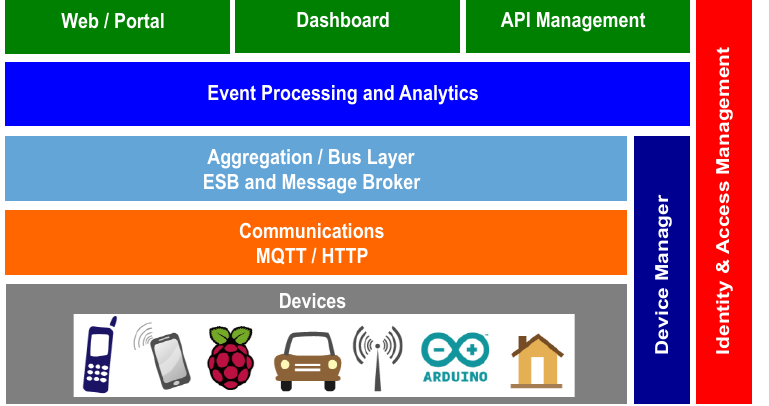
Figure 2. Internet of Things Reference Architecture